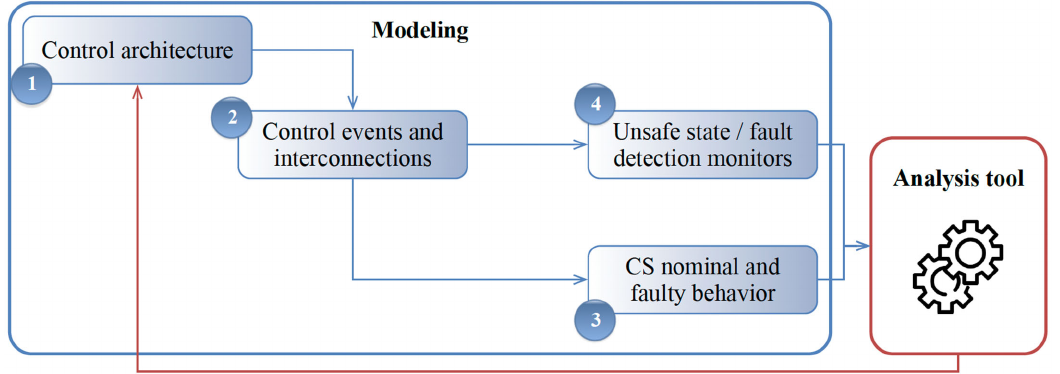
Figure 5. Modeling activities flows for ATG and its relationships to the analysis tool.